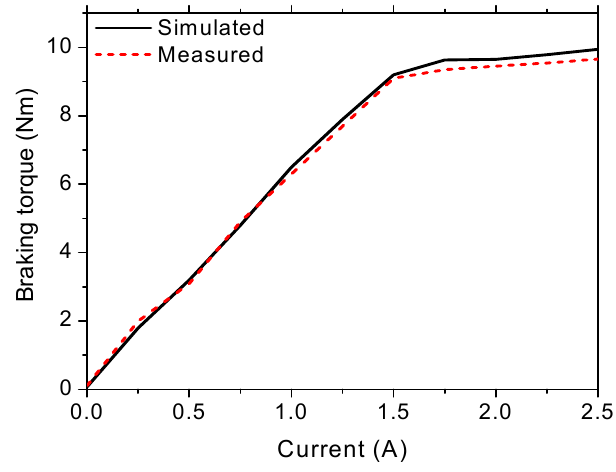
Figure 13. Braking torque of the waist MR brake vs. applied current.